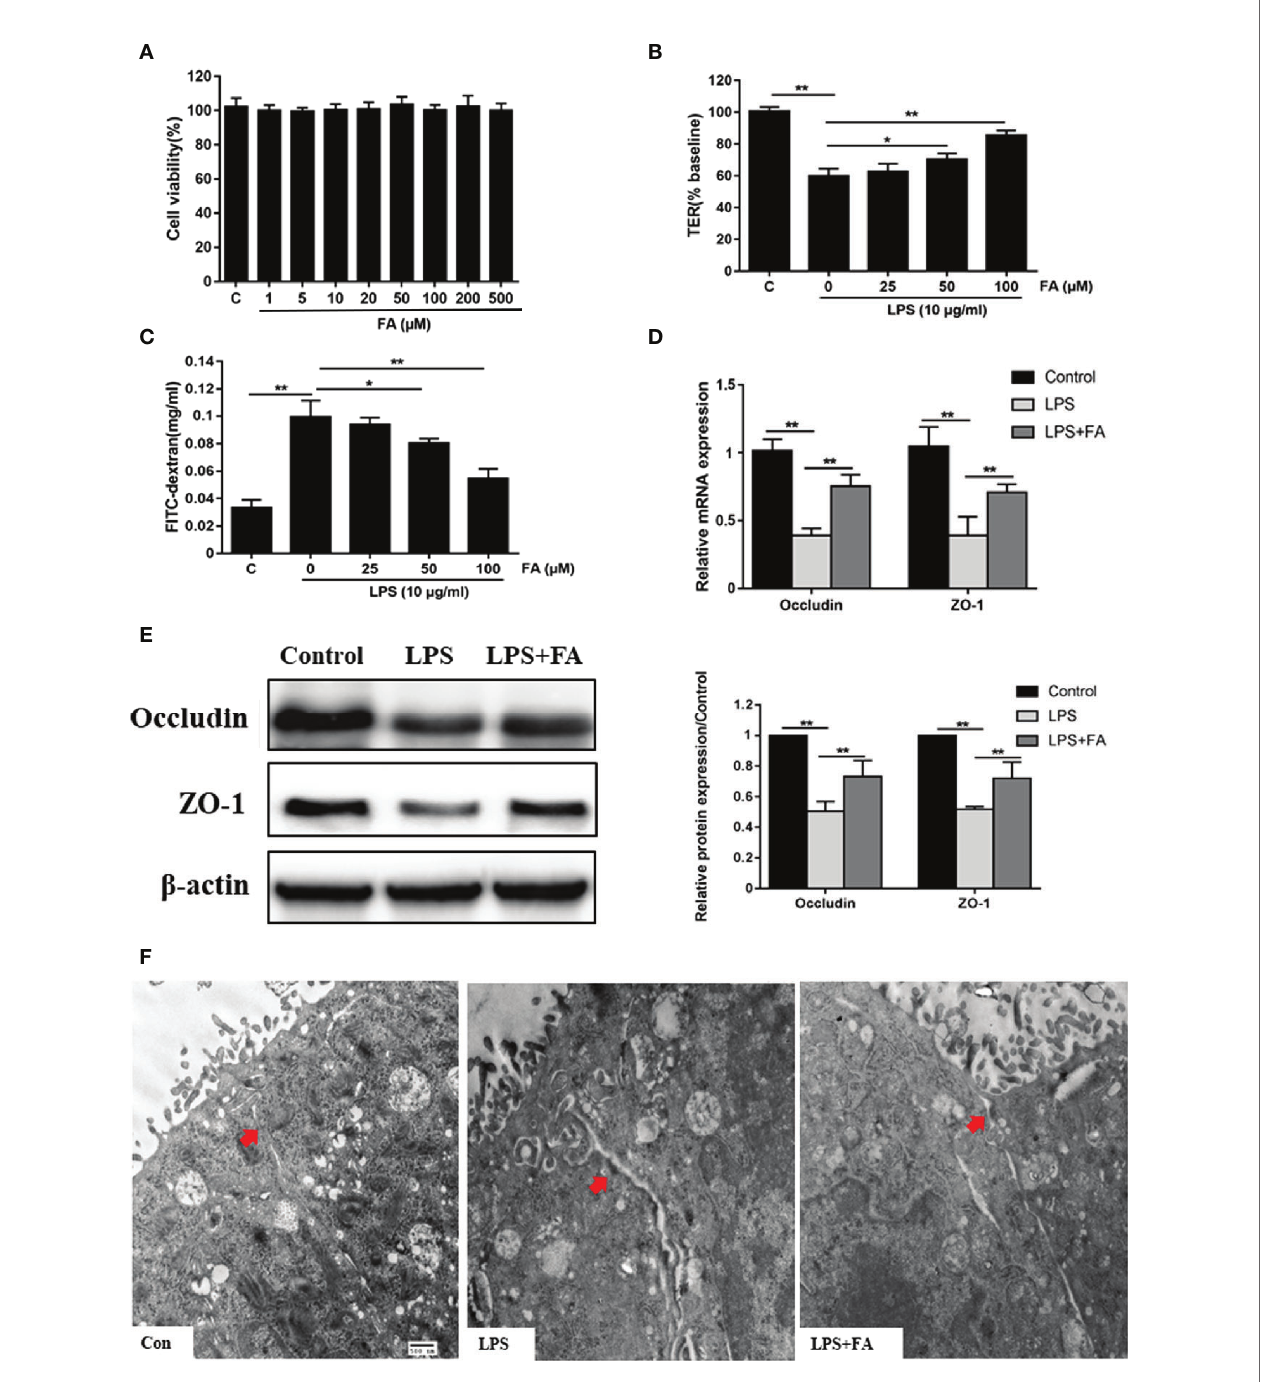
FIGURE 2 | The protective effects of FA on LPS-induced intestinal epithelial barrier dysfunction. (A) Caco-2 cells were incubated with FA (0 - 500 m M) for 48 h and then CCK-8 assay was used to detect cell viability. (B, C) Cells were pretreated with FA (25, 50, 100 m M) for 2 h and then stimulated with LPS for 24 h. TER and FD4 fl ux were measured to evaluate the paracellular permeability. (D, E) Caco-2 cells were pretreated with 100 m M FA for 2 h and then stimulated with LPS for 24 h. The mRNA and protein expression levels of occludin and ZO-1 were determined by qRT-PCR and Western blot analysis. (F) Ultrastructure of TJs in Caco-2 monolayers cell was observed with a transmission electron microscope (black arrow indicated, Scale bar = 500 nm). Data were presented as means ± SD from three independent experiments and differences between means were compared using one-way ANOVA with Tukey ’ s multiple comparisons test. * P < 0.05, ** P <